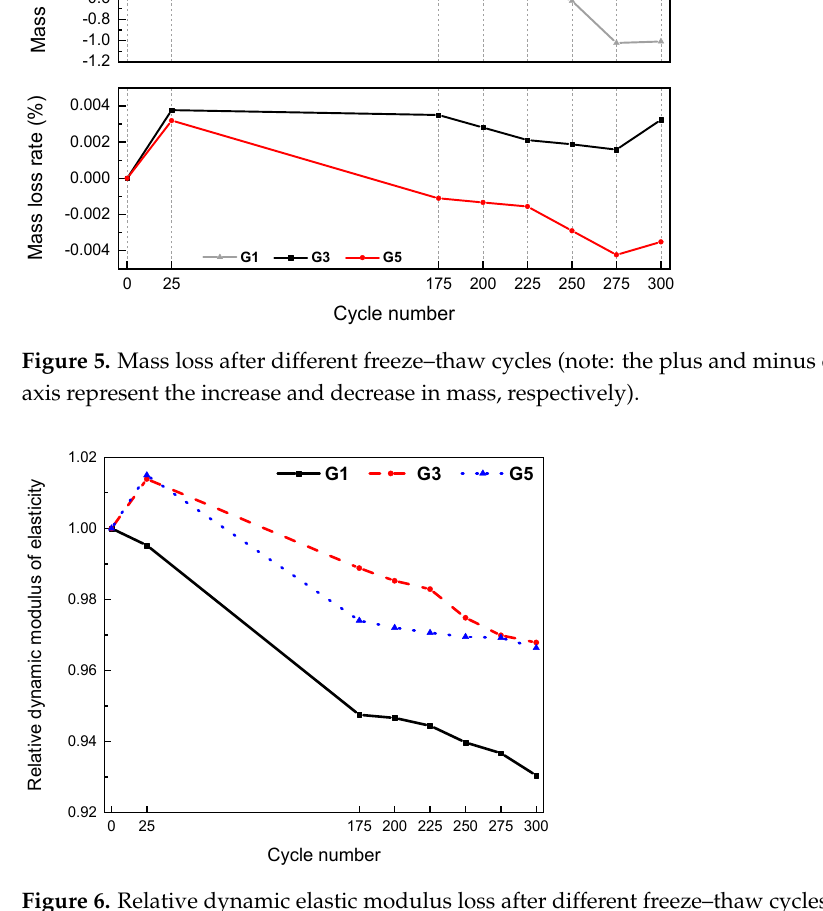
Figure 6. Relative dynamic elastic modulus loss after different freeze–thaw cycles.